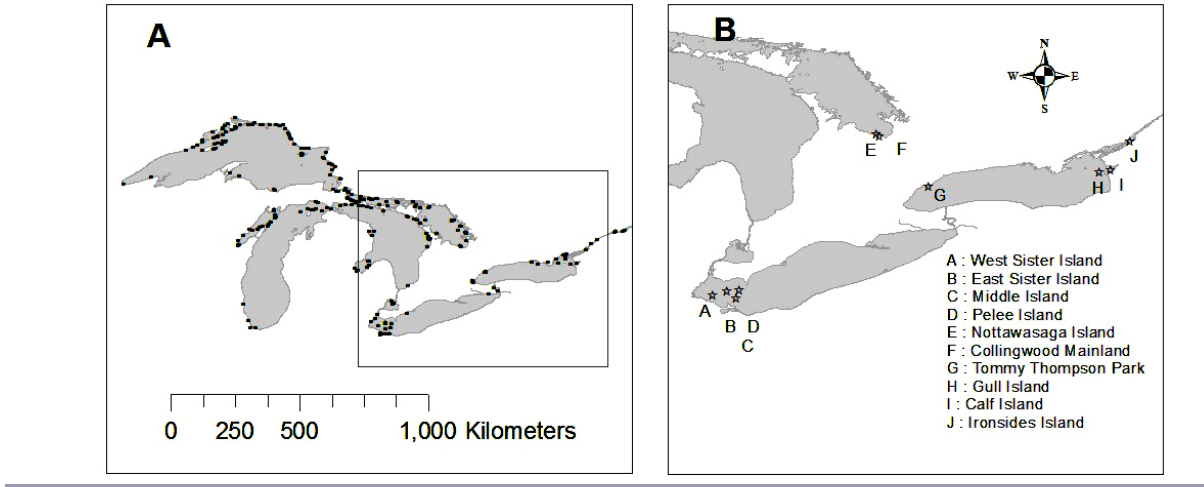
Fig. 1 . The distribution of Black-crowned Night-Heron, Great Egret, and Great Blue Heron colonies found during four decadal surveys. (A) Locations of all 78 colonies located in 1976-2009. (B) Locations of colonies showing the greatest change in numbers,